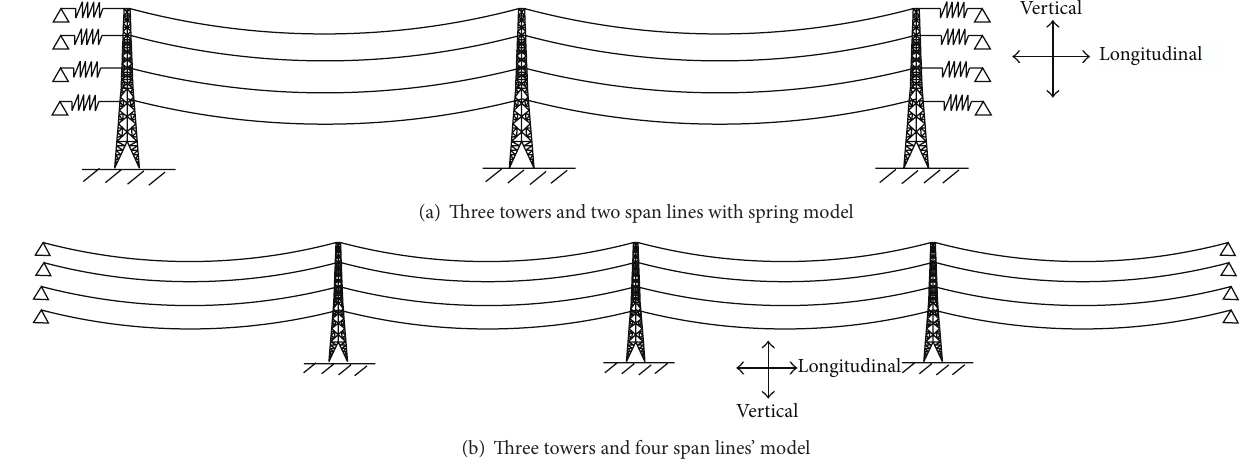
Figure 2: Suspension type transmission tower-line system models.